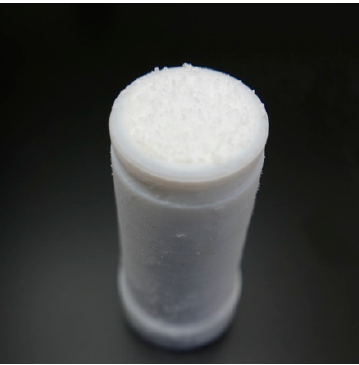
Figure 1. A typical sample of methane hydrate while in the Teflon cylindrical mold.